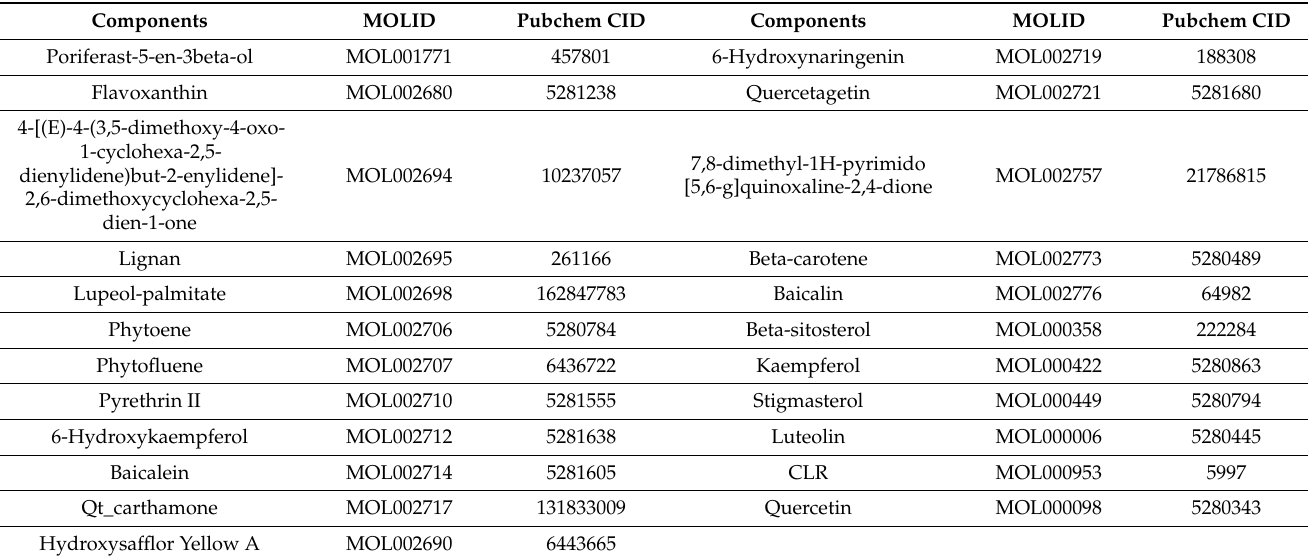
Table 1. The 23 bioactive components of HH found in databases and literature.